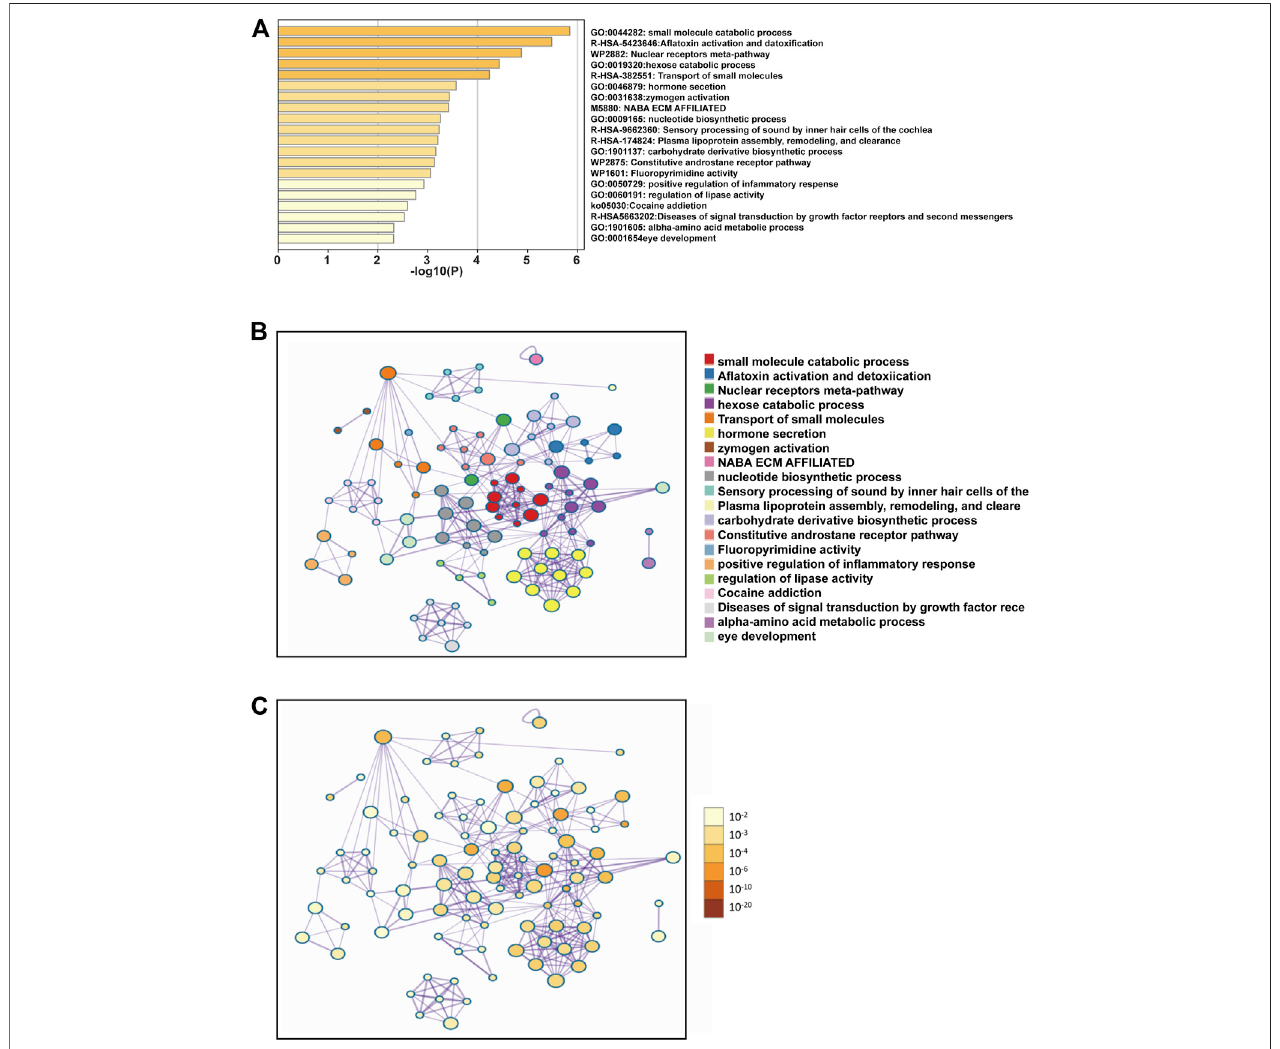
FIGURE 5 | Functional enrichment analysis of the co-expressed genes of SEMA5B. (A) Bar graph of enriched terms across co-expressed genes constructed by Metascape, colored by p -values. (B) Interactive network ofthe top 20 enriched terms colored bycluster ID. (C) Interactive network ofthe top 20 enriched terms colored by p